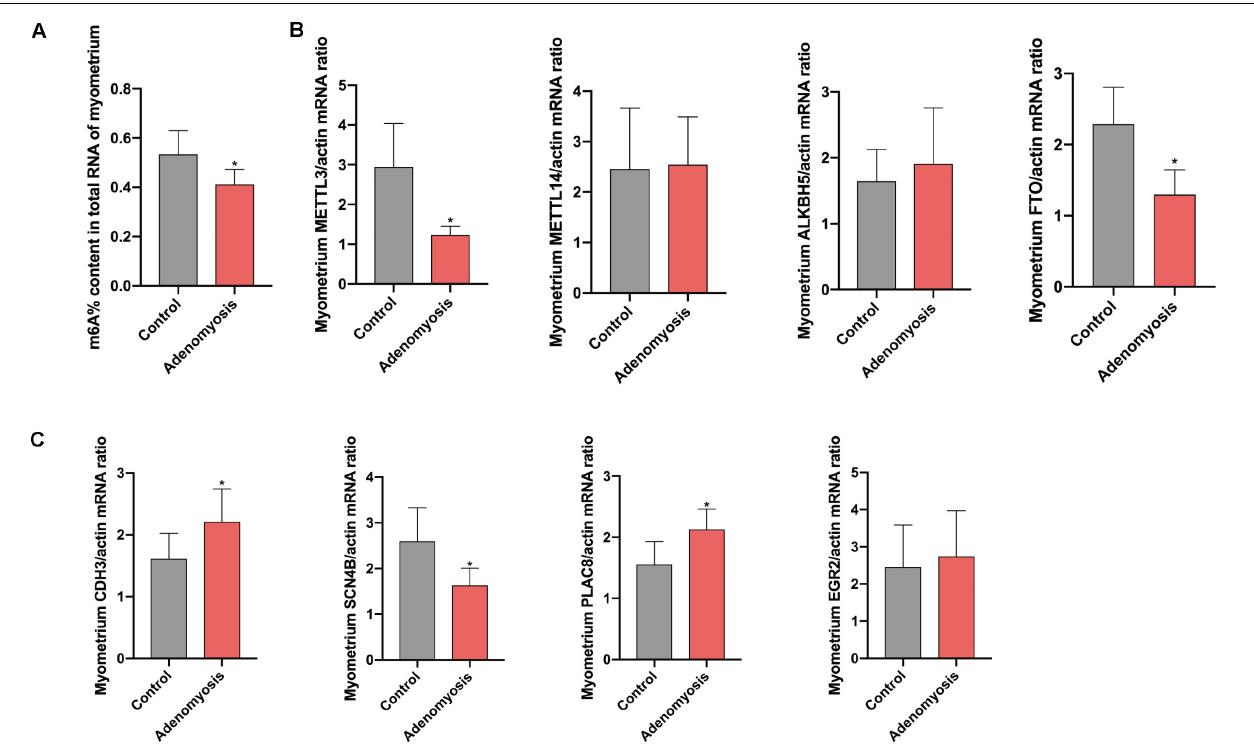
FIGURE 7 | The total m 6 A level and qRT-PCR validation of bioinformation data in myometrium of women with and without adenomyosis. (A) m 6 A% content in total RNA in the myometrium of adenomyosis and control patients. (B) The expression of METTL3 , METTL14 , ALKBH5 , FTO mRNA level in the myometrium. (C) The expression of CDH3, SCN4B, PLAC8 , and EGR2 mRNA level in the myometrium. n = 6 for each group. * p < 0.05.